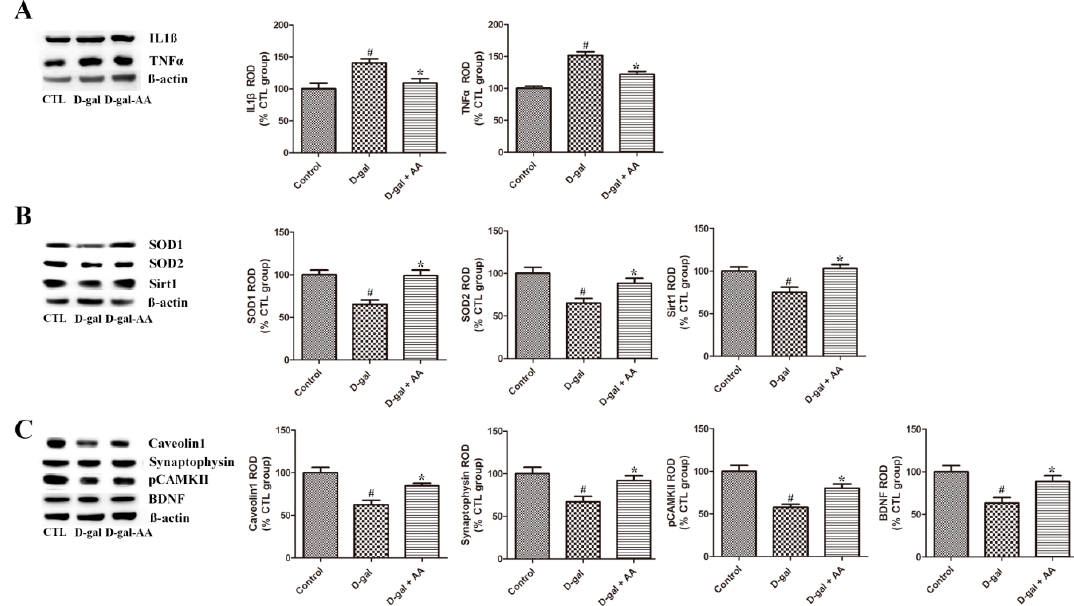
Figure 5. Western blot analysis of interleukin 1 beta (IL1 β ) and tumor necrosis factor alpha (TNF α ) ( A ), superoxide dismutase 1 (SOD1), SOD2, and sirtuin 1 (Sirt1) ( B ), caveolin-1, synaptophysin, phosphorylated Ca 2 + / calmodulin-dependent protein kinase (pCAMK) II, and brain-derived neurotrophic factor (BDNF) ( C ) in the hippocampus in control (CTL), D-galactose (D-gal), and ascorbic acid (150 mg / kg; AA)-fed D-gal groups. Relative optical density (ROD) of immunoblot bands is defined as a percentage of the value of the control group ( n = 7 per group; # p < 0.05, indicating a significant difference between control and D-gal groups; * p < 0.05, indicating a significant difference between D-gal and D-gal + AA groups). Data are presented as means ± SEM.